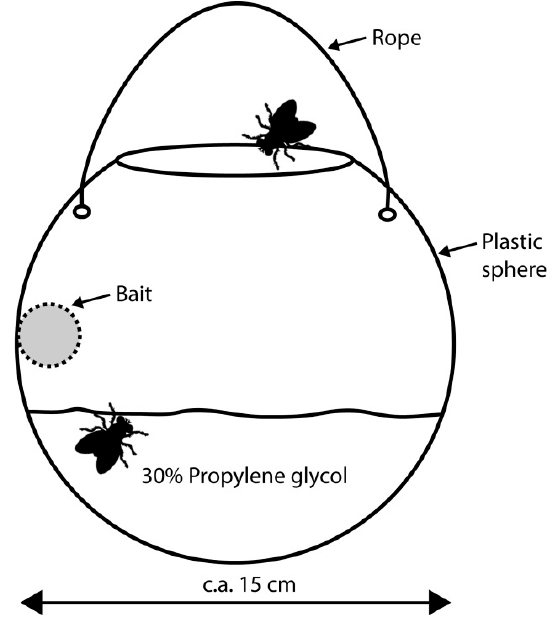
Figure 1. Modified McPhail trap ( D ).